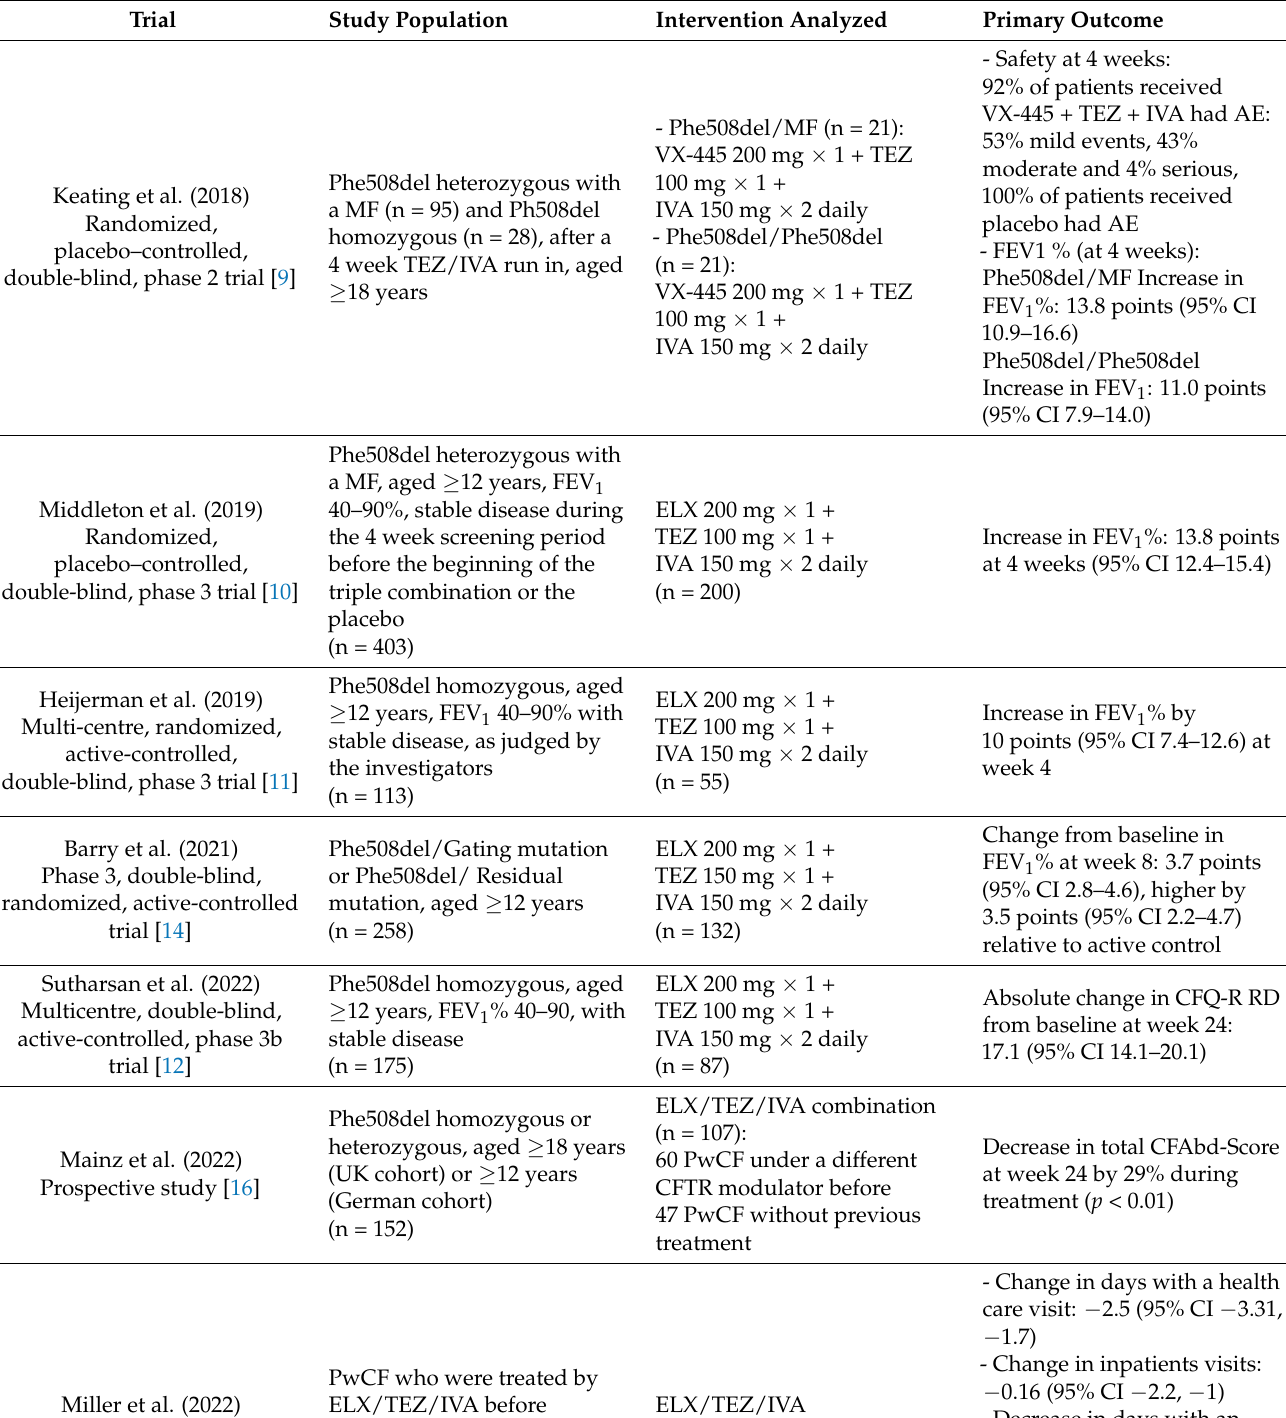
Table 1. Summary of characteristics and results of case-control studies examing the effect of